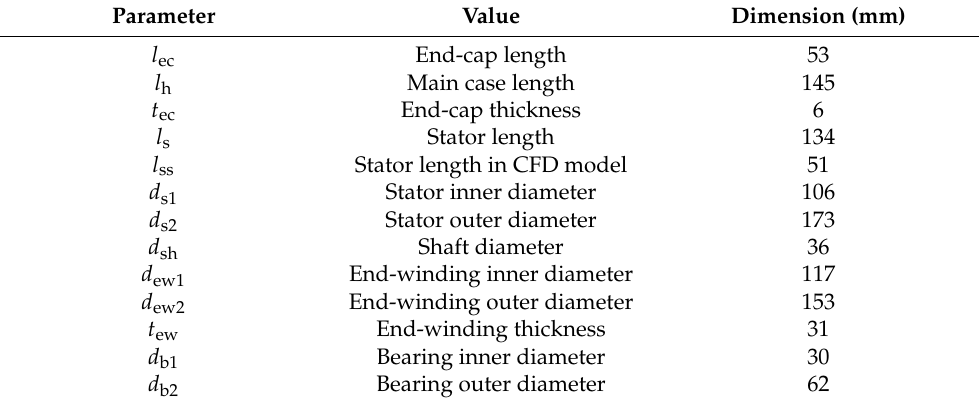
Table 4. Geometric parameters of the CFD model (Figures 5 and 6).